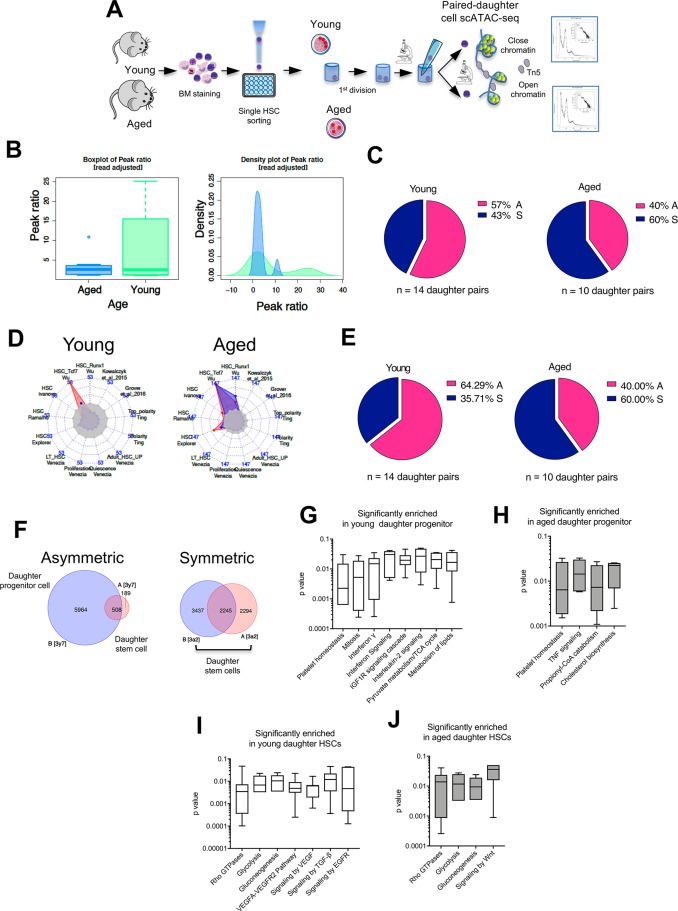
scATAC-seq on daughter cells shows asymmetric division for young HSCs, while aged HSCs undergo mainly symmetric divisions.(A) Schematic representation of the experimental setup for the preparation of scATAC-seq libraries from young and aged daughter cell pairs. Graphical sources: https://www.servier.de/medical-art and https://openclipart.org/. (B) Ratio of number of peaks of daughter pairs in young (green) and aged (blue) cells. For each pair, the ratios have been adjusted with the ratio of mapped reads in the pair (unadjusted ratios are shown in S11C Fig). A ratio of one represents an equal number of peaks in a given pair. The right panel represents the distribution of the ratio of peak counts. (C) Pie charts depicting the percentage of asymmetric and symmetric divisions of young and aged HSCs based on scATAC-seq analysis of daughter cells (see also S8 Table for statistics). For those pairs for which we have sufficient number of peaks for the reshuffling simulation test of the null hypothesis that cells in a pair show same peak counts in same genomic positions (column V in S8 Table), the asymmetry assignment is based on the significance of no overlap and on the ratio of peak counts (as a measure of global chromatin accessibility) greater than 2 (column P in S8 Table). (D) Radar plot based on 13 published “stemness” signatures. Signatures that show significant enrichment based on a hypergeometric test (adjusted p < 0.05) are shown by red and blue shades representing the 2 cells in a given pair. Signatures that do not extend beyond the shaded gray center are considered not significant (see S14 Fig. for the reference to each specific signature). (E) “Stemness” enrichment analysis-based pie charts showing the frequency of symmetric and asymmetric division of young and aged HSCs. A goodness-of-fit chi-squared test assessing the matches in significance between cells in a pair was used to assign cells either as symmetric or asymmetric. (F) Example of a Venn diagram depicting an asymmetric (left panel; significant difference in peak counts) and a symmetric (right panel; comparable peak counts) daughter cell pair from young HSCs based on the difference in peak counts (ratios) as a measure of the degree of chromatin accessibility. For symmetrically dividing HSCs, both daughter cells were considered daughter stem cells (supported by our sc-transplant data). For asymmetrically dividing HSCs, the daughter presenting with the lower amount of peak counts (lower degree of chromatin accessibility) was considered the daughter stem cell, while the other daughter cell was assigned to the daughter progenitor (i.e., not stem cell) group. (G, H) Daughter progenitor cells were subjected to Reactome GO analysis. The most frequently significantly enriched GOs among young (panel G) and aged (panel H) daughter progenitor cells are shown. (I, J) Daughter stem cells were subjected to Reactome GO analysis. The most frequently significantly enriched GOs among young (panel G) and aged (panel H) daughter stem cells are shown. The primary data the figure is based on are provided in GEO GSE116712. A, asymmetric; GO, gene ontology; HSC, hematopoietic stem cell; S, symmetric; scATAC-seq, single-cell transposase-accessible chromatin sequencing.